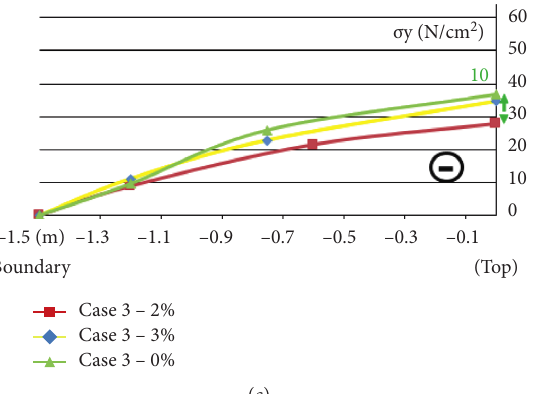
x of shell; (c) stress